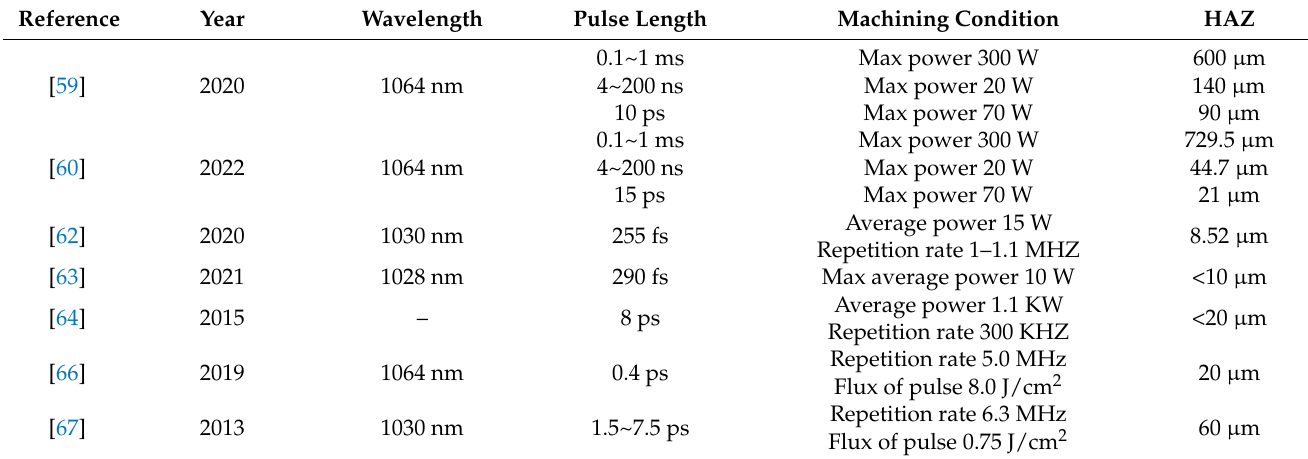
Table 2. Effect of pulse width on heat-affected zone.